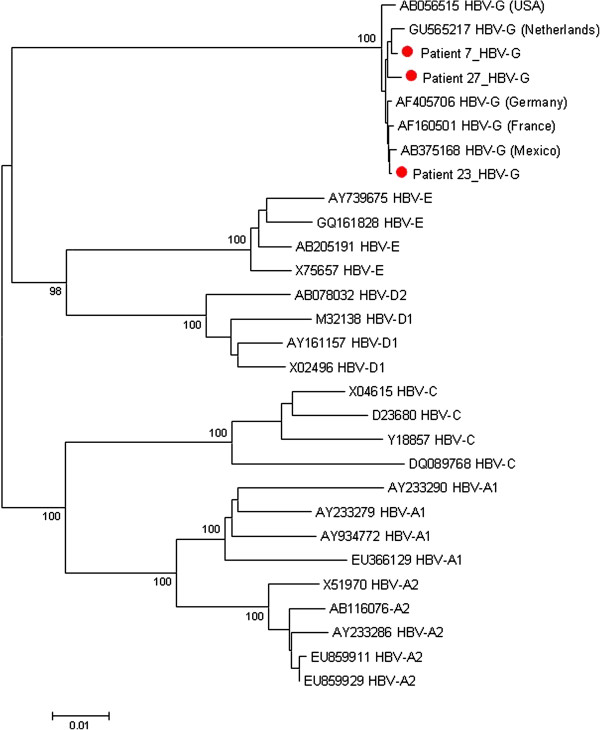
Phylogenetic analysis of full-length HBV sequences. The neighbour-joining tree was generated with the MEGA5 software package [38] and shows the relationship between three novel, full-length HBV-G strains from the Netherlands (indicated by red circles) and reference sequences of HBV genotypes A1, A2, C, D1, D2 and G obtained from the NCBI nucleotide database [35]. Distances were estimated with the Kimura 2-parameter method, and bootstrap resampling was done with 1000 replicates. The accession number of the reference sequences is indicated together with the HBV genotype.